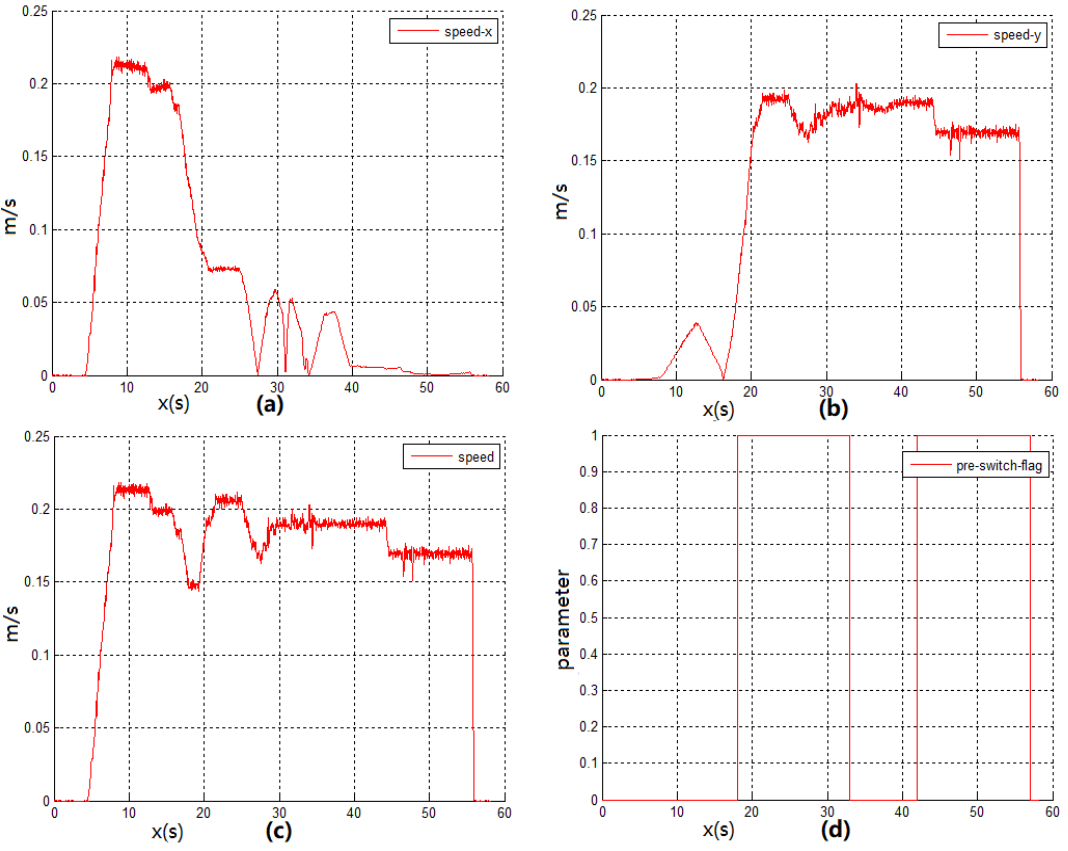
Figure 4. The speed and pre-switching flag of simulation robot waveform diagram. ( a ) X-axis speed curve ( b ) Y-axis speed curve ( c ) Comprehensive speed curve ( d ) Diagram of the pre-switching